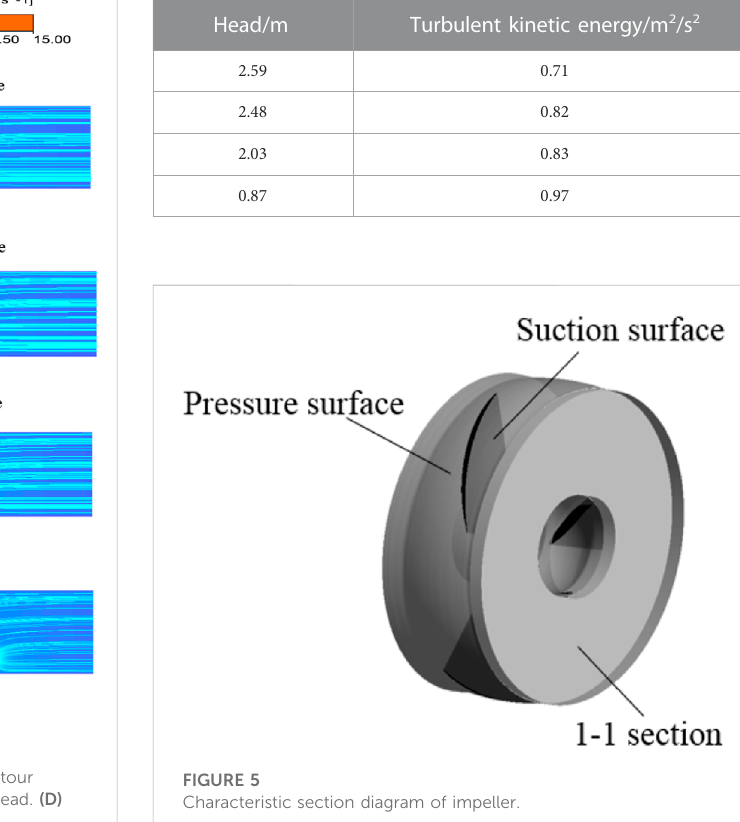
Characteristic section diagram of